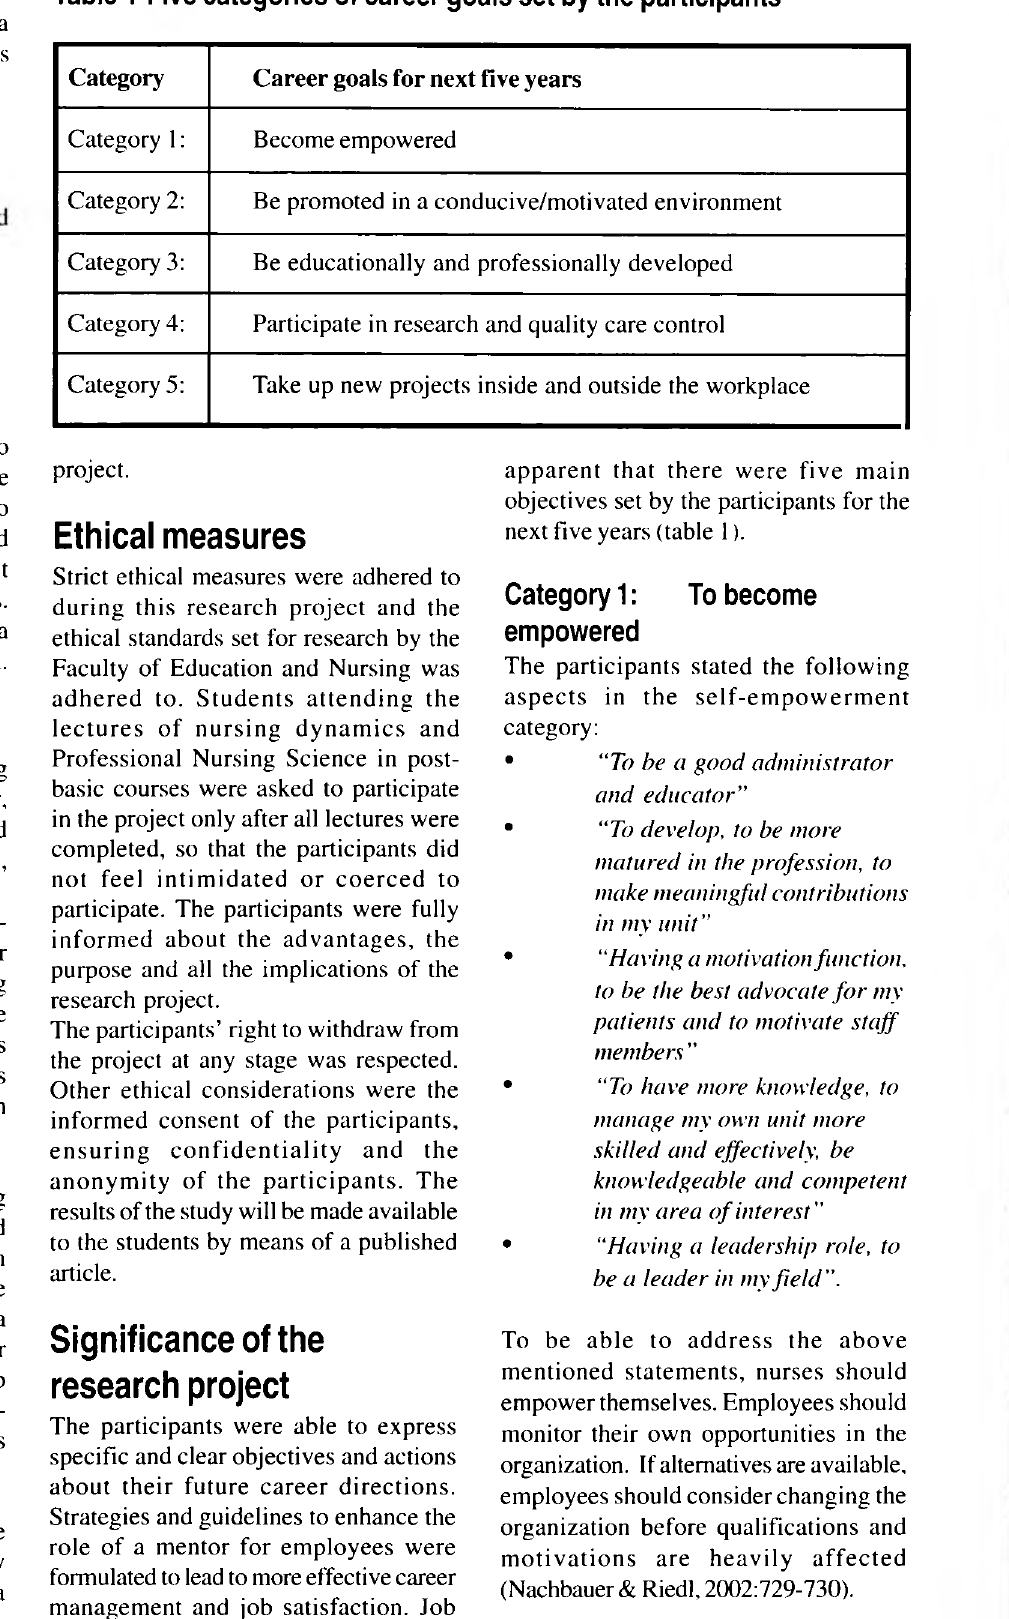
Table 1 Five categories of career goals set by the